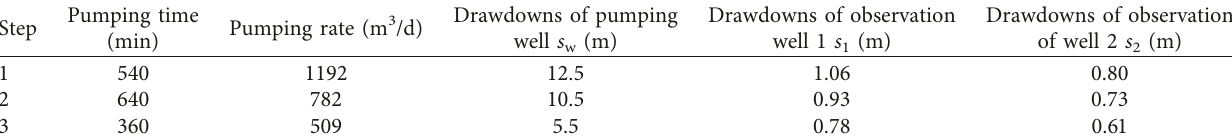
Table 3: Pumping rate, time, and depth in three steps.